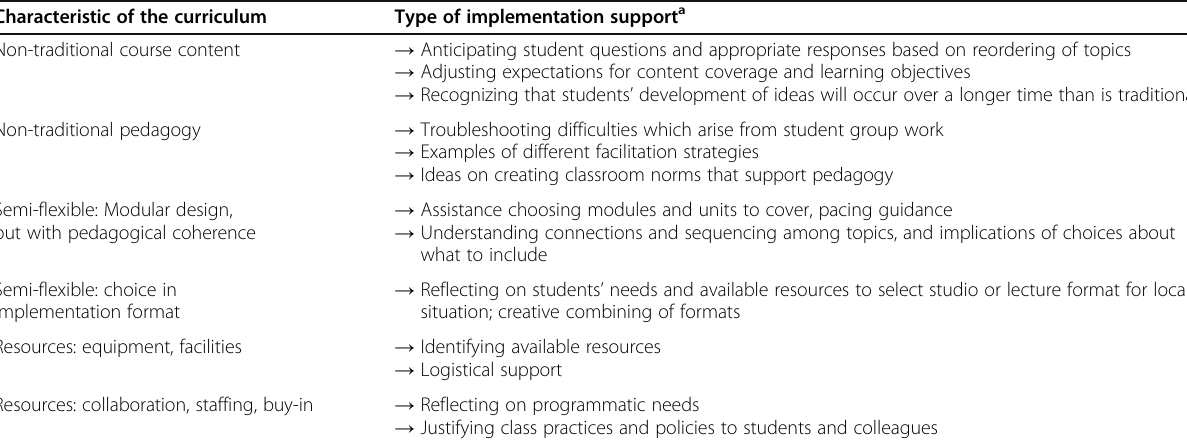
Table 1 Types of support Next Gen PET adopters may need Characteristic of the